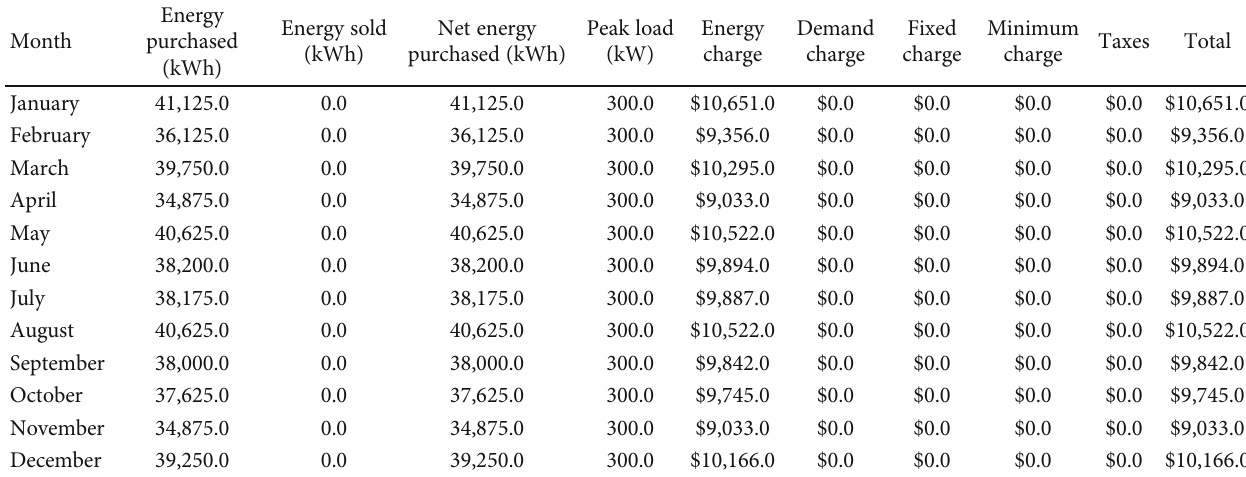
Table 8: Utility monthly summary for the base case.